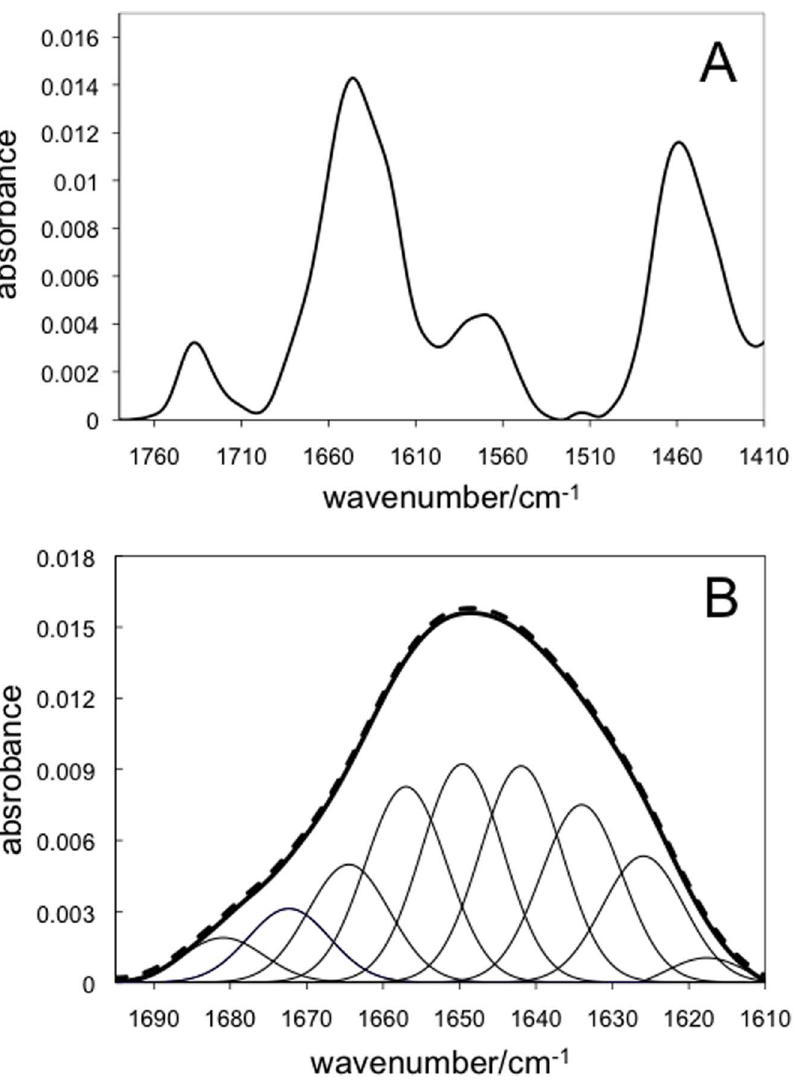
Figure 2. FTIR spectrum of rArom in D 2 0. A) FTIR spectrum of rArom obtained by depositing 20 m l of rArom (135 m M in 100 mM KPi pH 7.4 + 20% glycerol + 0.1% Tween 20 + 1 mM b -mercaptoethanol) on the germanium crystal of the ATR accessory. B) Deconvolution of the amide I band signal (thick line) into its nine components (thin lines). The experimental (solid thick line) and the predicted (dashed line) spectra are shown.